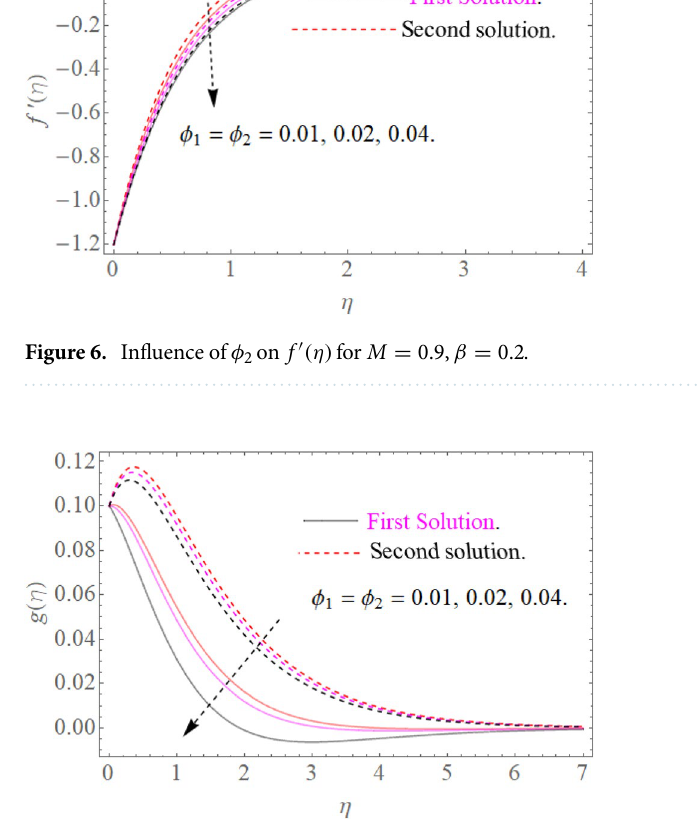
Figure 7. Influence of φ 2 on g (η) for M = 0.9, β = 0.2